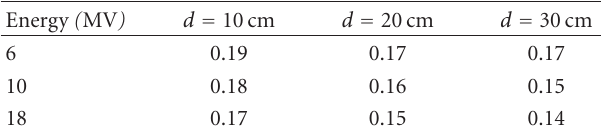
Table 4: The signal scatter fractions of CPID for three clinical beams. Statistical uncertainty for each value is ∼